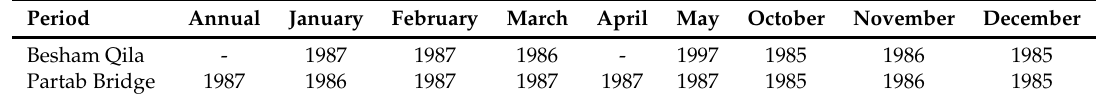
Table 5. Significant change points in river flows determined using the Pettitt test.